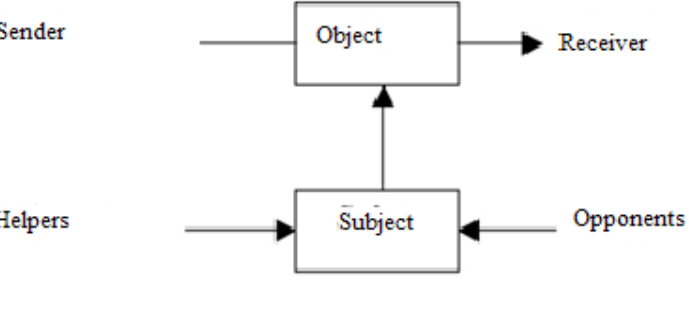
Figure 1. Actantial model of A. J. Greimas